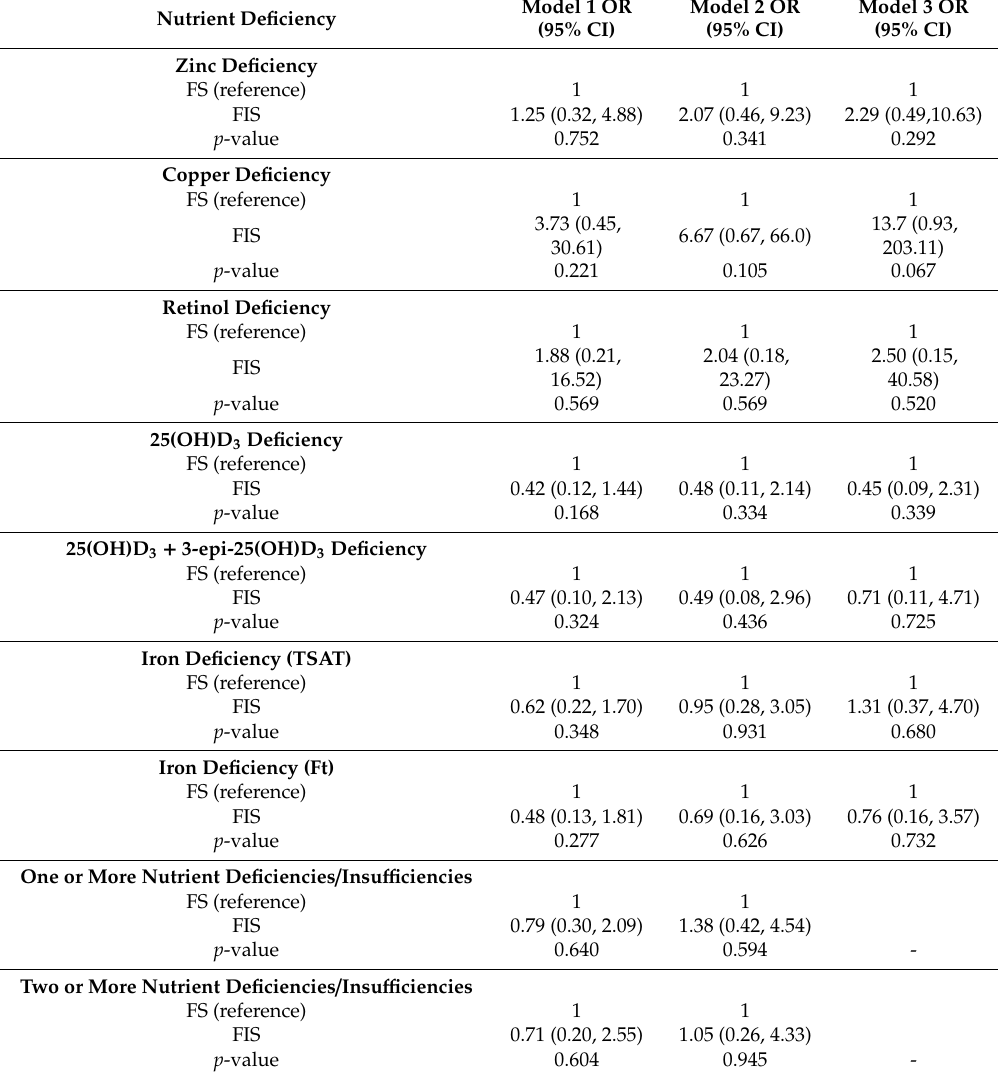
Table 3. Odds Ratios (OR) and 95% Confidence Intervals (CI) of micronutrient deficiencies or insu ffi ciencies according to food security status among Ghanaian women expecting to become